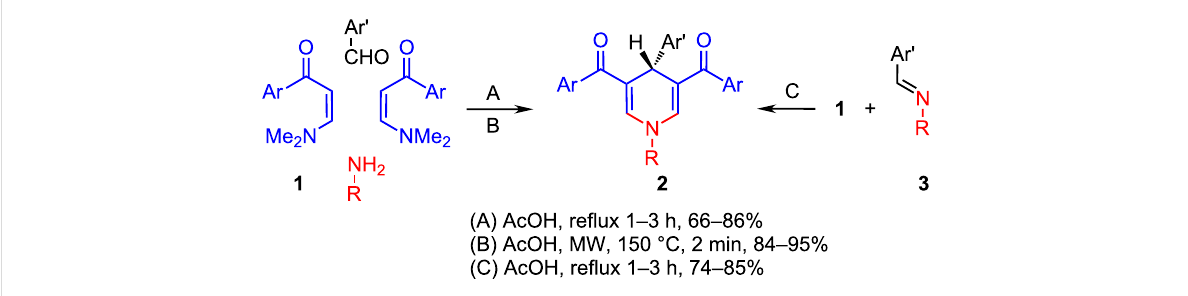
Scheme 2: Synthesis of dihydropyridine derivatives from enaminones.